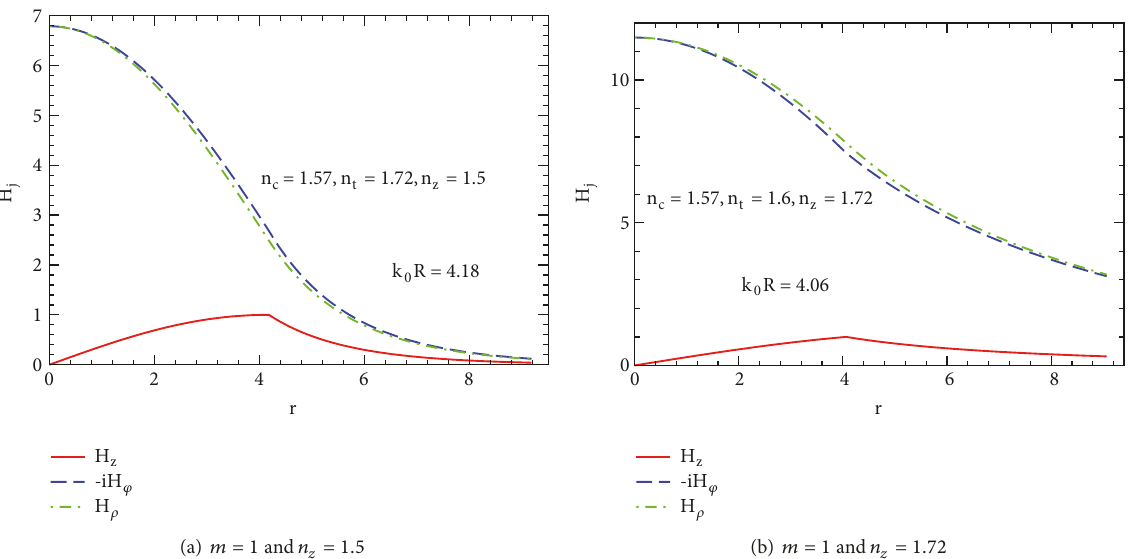
Figure 7: Components of electromagnetic field as a function of the dimensionless radial parameter 𝑟 = 𝑘 0 𝜌 for the mode with 𝑚 = 1 at (a) 𝑛 = 1.5 and (b) 𝑛 = 1.72 . 𝑧 𝑧